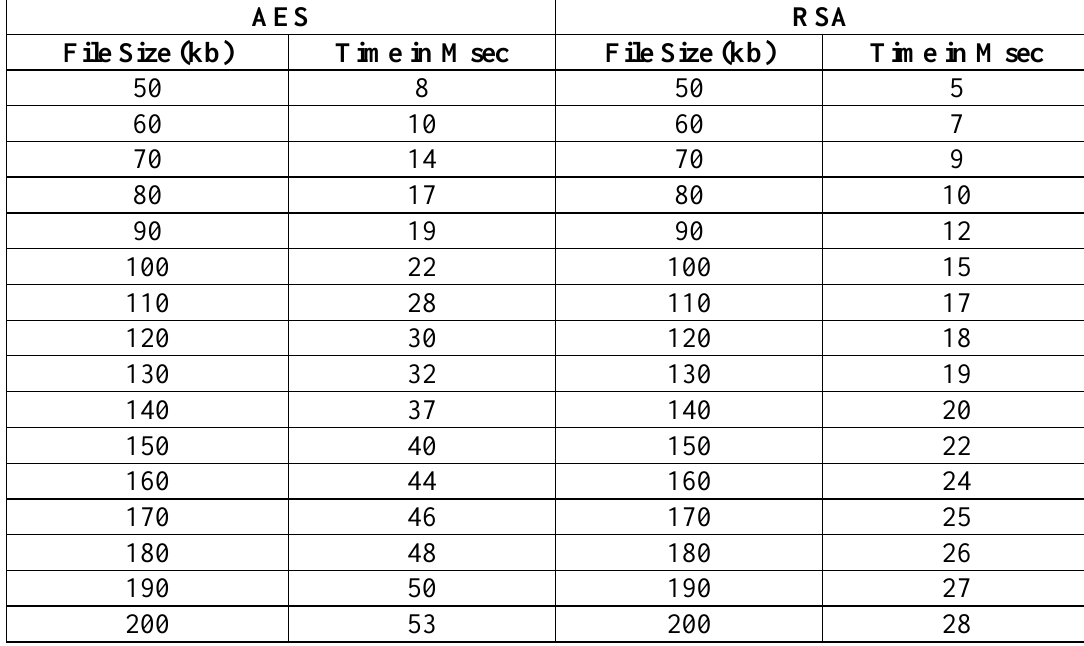
Table 5. File Downloading Time of AES and